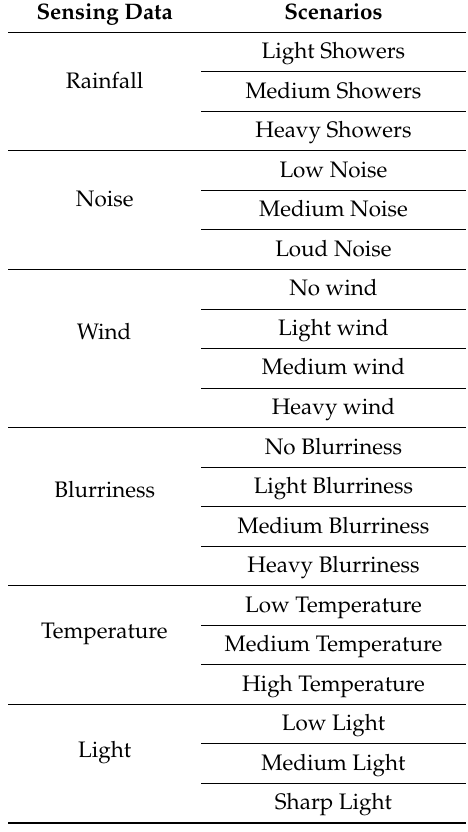
Figure 5. Event building from context in inference engine. Table 2. Environment sensing data scenario classification for building